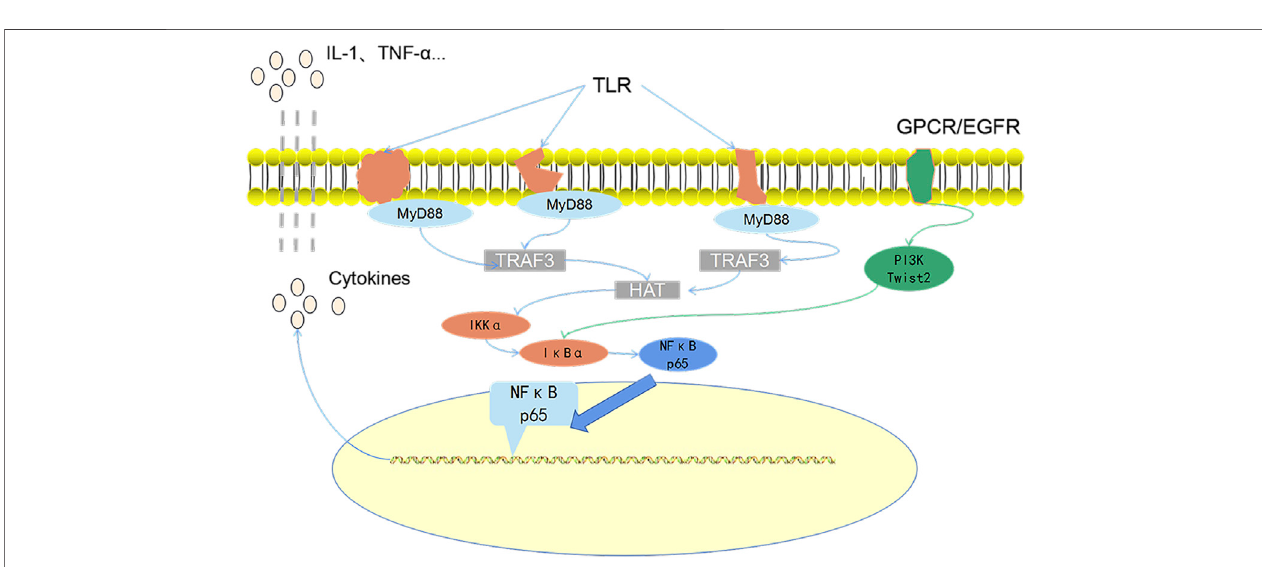
FIGURE 10 | The core role path diagram. MP is speci fi cally recognized by toll-like receptors and then promotes the activation of the NF- κ B pathway by promoting the expression of MyD88 protein. This is also the main path of MPP pathogenesis. Both G-protein – coupled receptors and EGF receptors that can pass the direct or indirect pathway is positively correlated with the NF- κ B